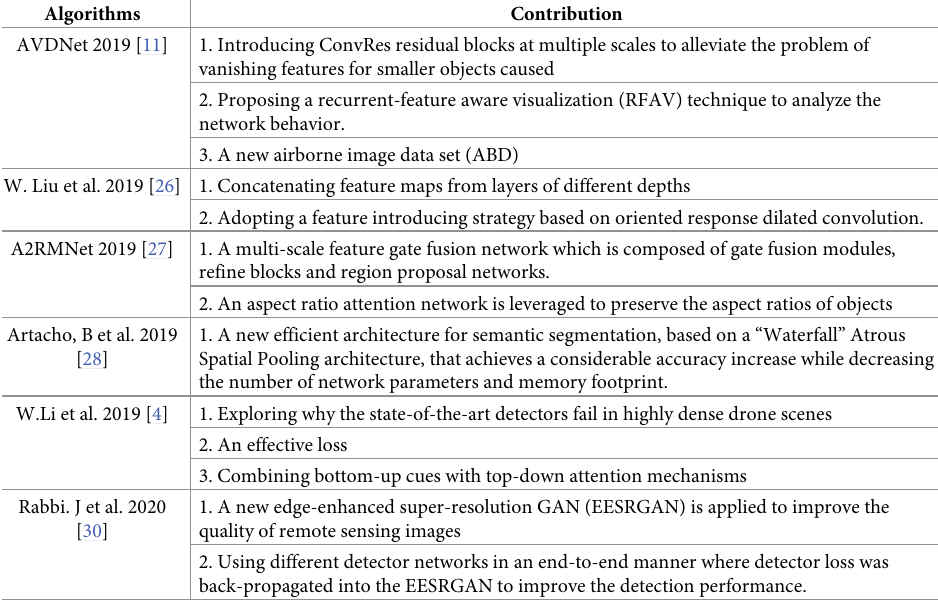
Table 1. The summarize of the significant related work and